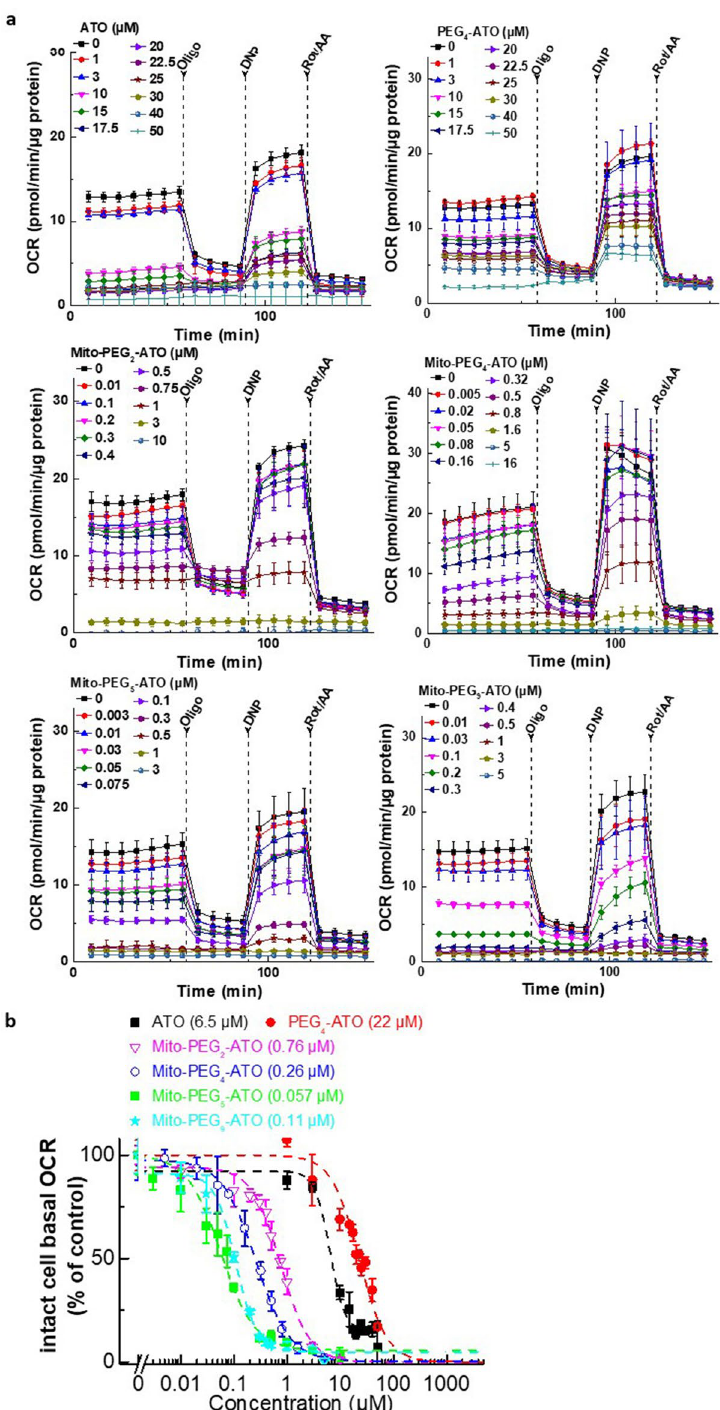
Figure 3. Effects of Mito-PEG-ATO analogs on intact cell mitochondria oxygen consumption of human pancreatic cancer (MiaPaCa-2) cells. ( a ) MiaPaCa-2 cells were treated with Mito-PEG-ATO analogs for 24 h, and concentration-dependent inhibition of mitochondrial respiration (OCR) in intact MiaPaCa-2 cells by Mito- PEG-ATO analogs was measured. ( b ) After eight baseline OCR measurements, the response to mitochondrial modulators (oligomycin, dinitrophenol, and rotenone/antimycin A as described in the Methods section) were recorded. The last three stable baseline OCR reading before oligomycin injection were plotted against the concentration of Mito-PEG-ATO analogs. Dashed lines represent the fitting curves used to determine the IC 50 values as indicated. Data shown are the mean ±